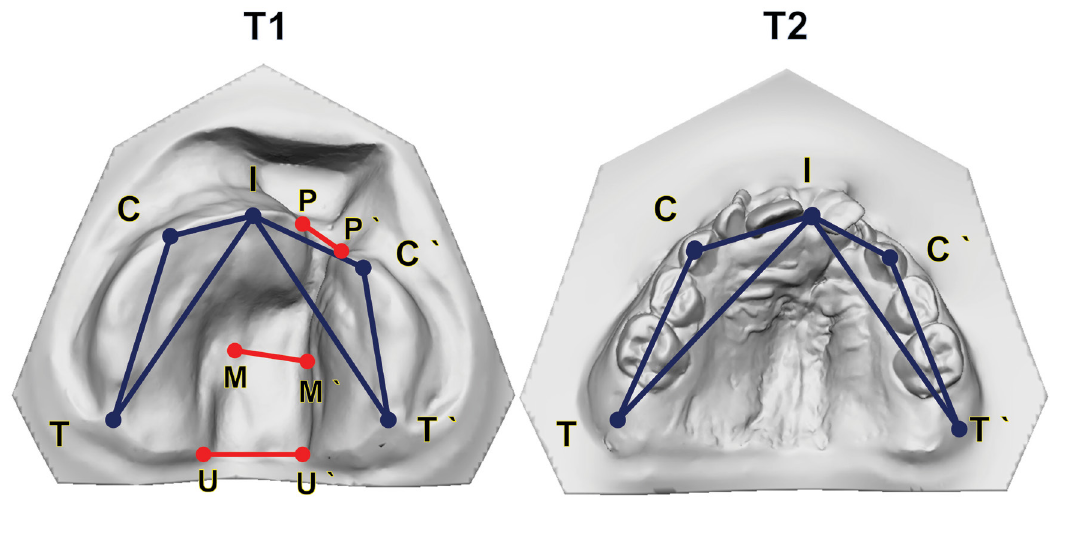
Figure 1. Dental arches at T1 and T2 showing the anatomic landmarks, cleft width, and linear parameters for the palate.